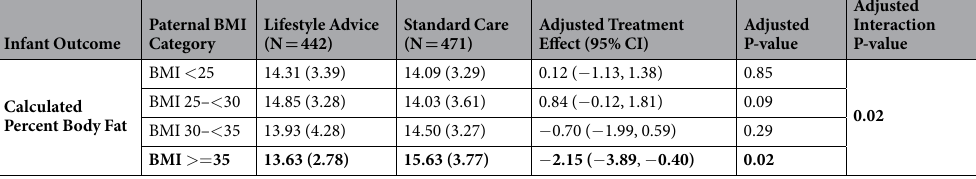
Table 3. Treatment effect modification of infant morphology, according to paternal body mass index category. Values are mean (SD) and treatment effects are differences in means. Where the interaction p-value is not significant, treatment group comparisons within subgroups should be interpreted with caution. Results have been adjusted for centre, maternal parity, maternal BMI, maternal age, socioeconomic status and maternal smoking status. * Calculated using equation from Deierlein et al . 42 . Note that ‘ethnicity’ (Hispanic vs non- Hispanic) is included in this equation but is not applicable to the LIMIT cohort (all participants are ‘non-